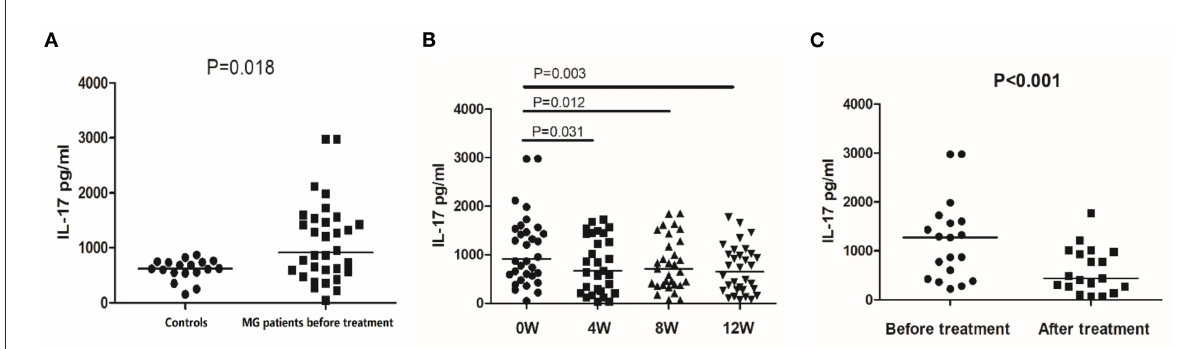
FIGURE3 IL-17 secretion detected by ELISA in controls and MG patients. (A) IL-17 secretion in PBMCs of healthy controls and MG patients before treatment. (B) IL-17 secretion in PBMCs of MG patients before treatment and after 4, 8, and 12 weeks of treatment. (C) IL-17 secretion in PBMCs of responsive MG patients before treatment and at 12 weeks. The horizontal bars indicate the median. The amount of IL-17 secretion was a continuous variable with a non-normal distribution; We compare MG patients and controls using Welch’s corrected unpaired rank sum test. We compared before and after treatment using a paired rank sum test.